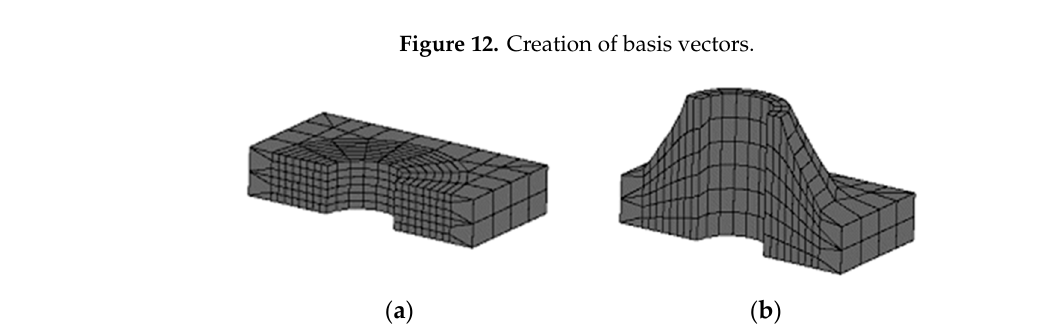
Figure 13. A shape designation portion.